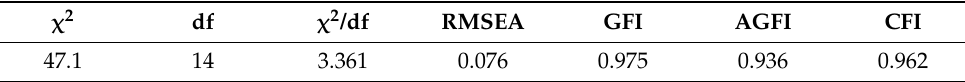
Table 5. Confirmatory factor analysis of the PrEP adherence questionnaire.